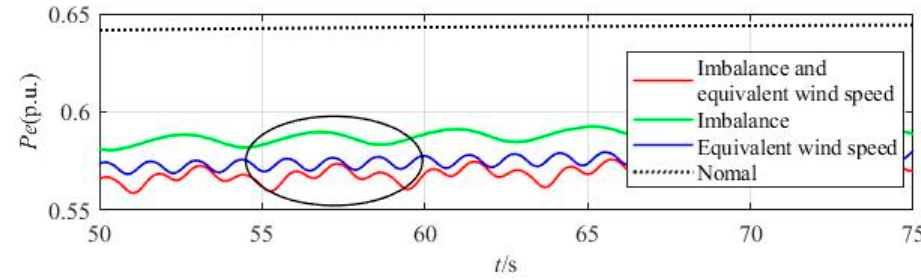
Figure 9. Electromagnetic power time-domain waveform.